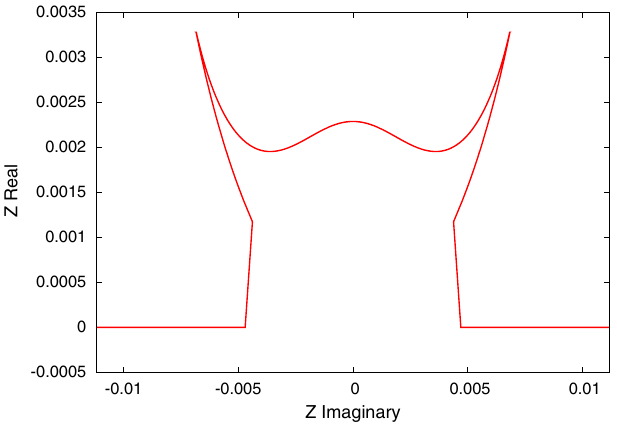
FIG. 6. The curve shows the marginal stability boundary for the energy distribution of Fig. 5 and was generated using Eq. (2). The scales depend on the detailed parameters and are described in the